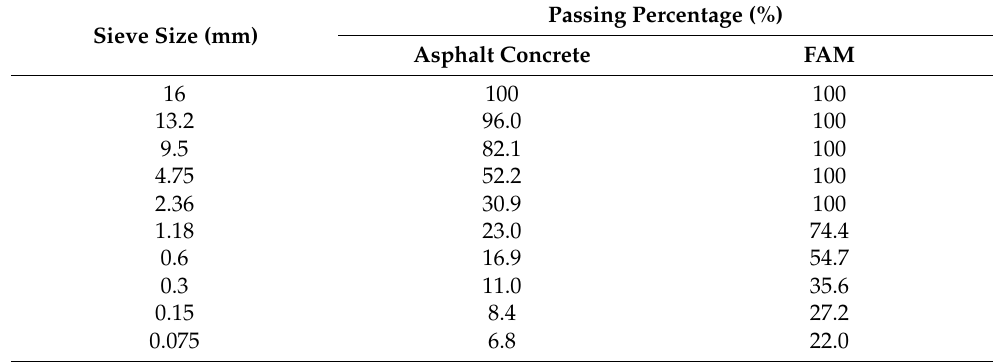
Table 1. Aggregate